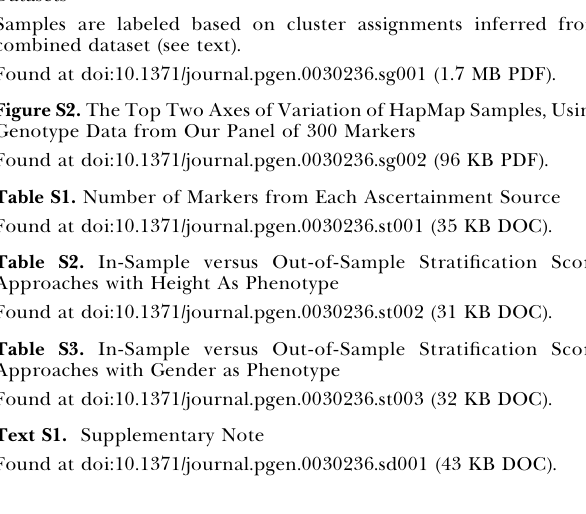
Figure S1. The Top Two Axes of Variation of MS, BD, PD, and IBD Datasets Samples are labeled based on cluster assignments inferred from combined dataset (see text). Found at doi:10.1371/journal.pgen.0030236.sg001 (1.7 MB PDF). Figure S2. The Top Two Axes of Variation of HapMap Samples, Using Genotype Data from Our Panel of 300 Markers Found at doi:10.1371/journal.pgen.0030236.sg002 (96 KB PDF). Table S1. Number of Markers from Each Ascertainment Source Found at doi:10.1371/journal.pgen.0030236.st001 (35 KB DOC). Table S2. In-Sample versus Out-of-Sample Stratification Score Approaches with Height As Phenotype Found at doi:10.1371/journal.pgen.0030236.st002 (31 KB DOC). Table S3. In-Sample versus Out-of-Sample Stratification Score Approaches with Gender as Phenotype Found at doi:10.1371/journal.pgen.0030236.st003 (32 KB DOC). Text S1. Supplementary